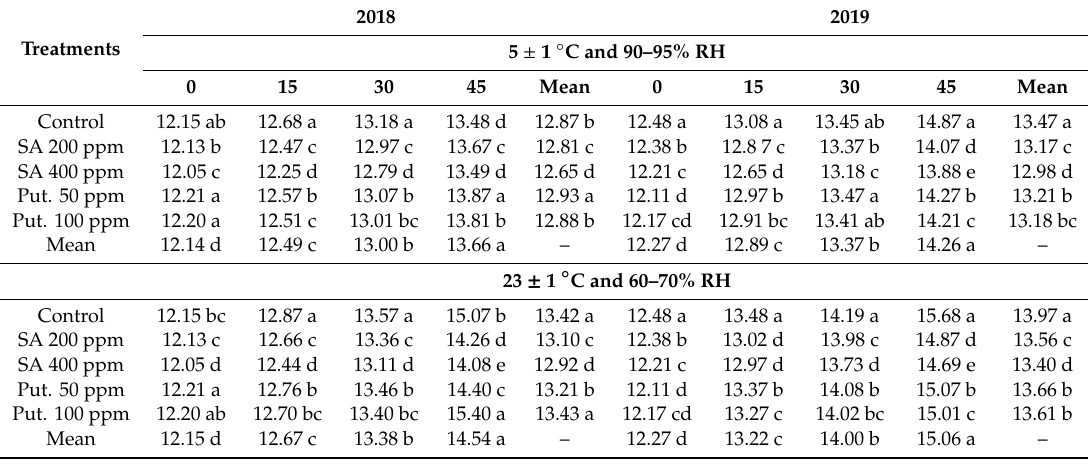
Table 4. E ff ect of salicylic acid (SA) and putrescine (Put) on TSS (%) of Murcott mandarin fruit at harvest and 15, 30, and 45 days of storage during 2018 and 2019 seasons.